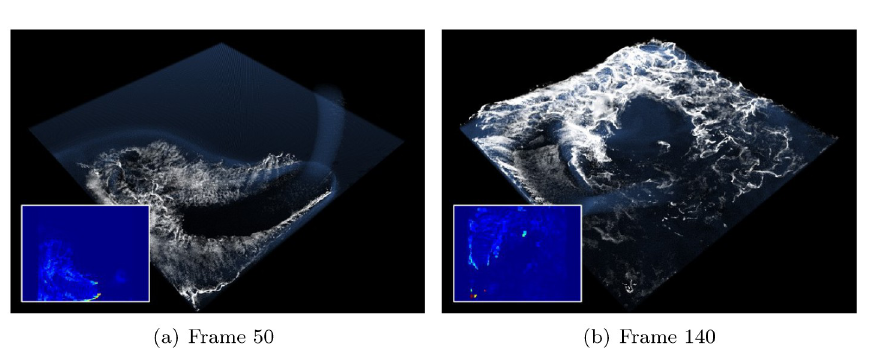
Fig 14. Foam effects with our method in a rotating-emitter (inset image: Acceleration map). (a) Frame 50, (b) Frame 140.